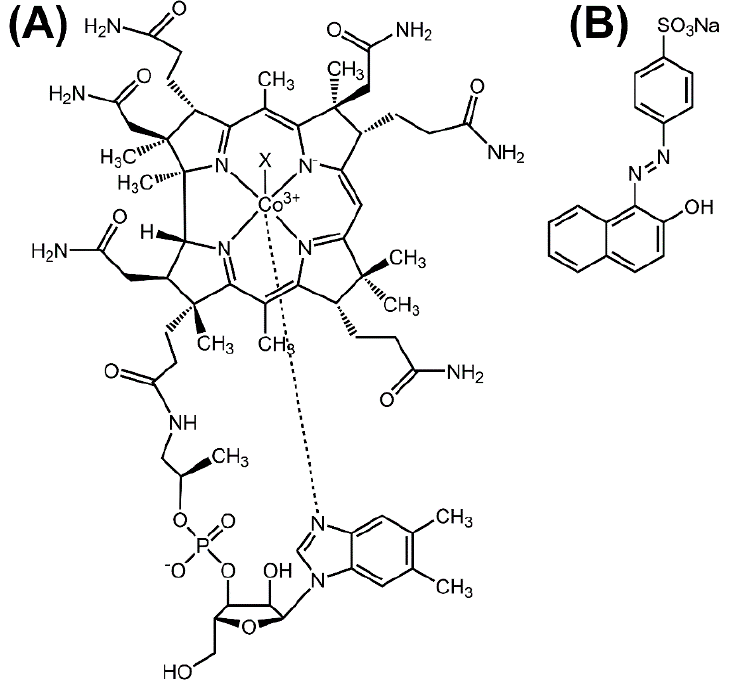
Figure 1. Structures of cobalamin ( A ; X = H 2 O; CN − and others) and Orange II ( B ).